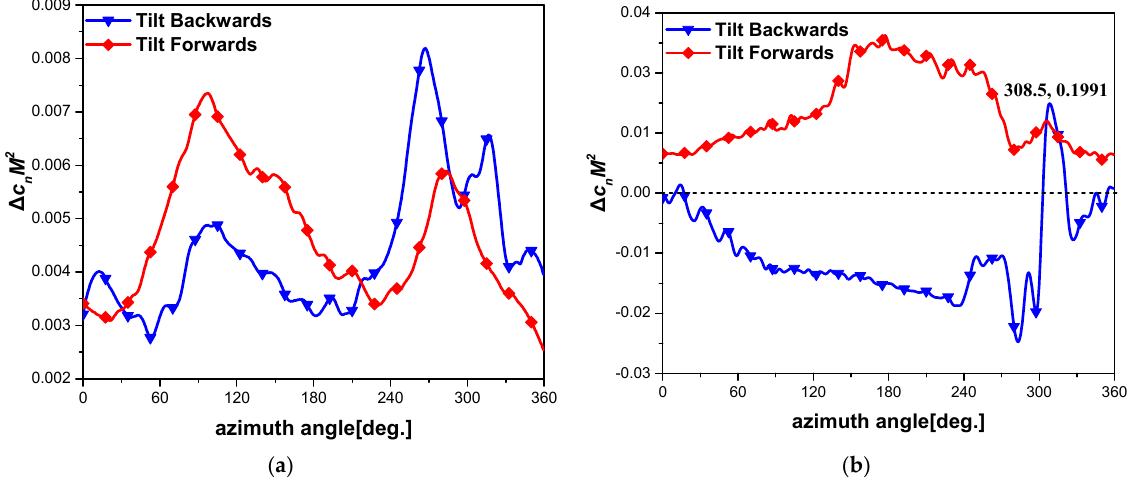
Figure 17. Normal force coefficient versus azimuth angle. ( a ) r/R = 0.5. ( b ) r/R = 0.7. ( c ) r/R = 0.75. ( d ) r/R = 0.8.